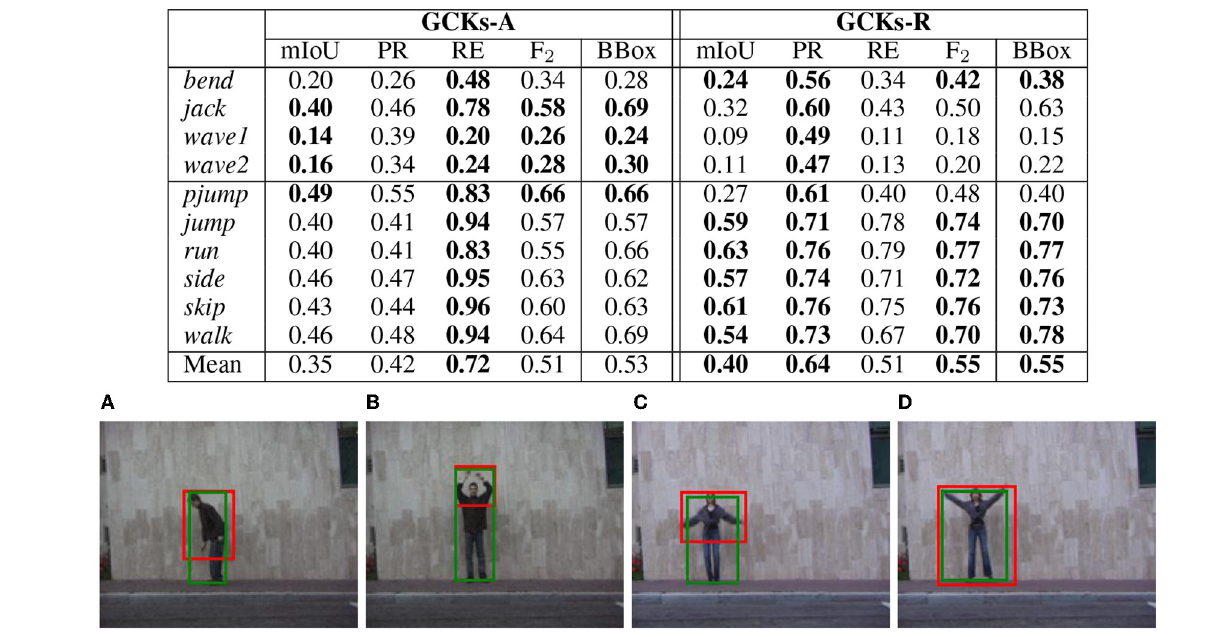
FIGURE 8 | Above: evaluation of the two segmentation step on the Weizmann Dataset. Below: samples frames with the detection (red: our detection; green: ground truth). (A) Bend, (B) wave, (C) jumping jack, and (D) jumping